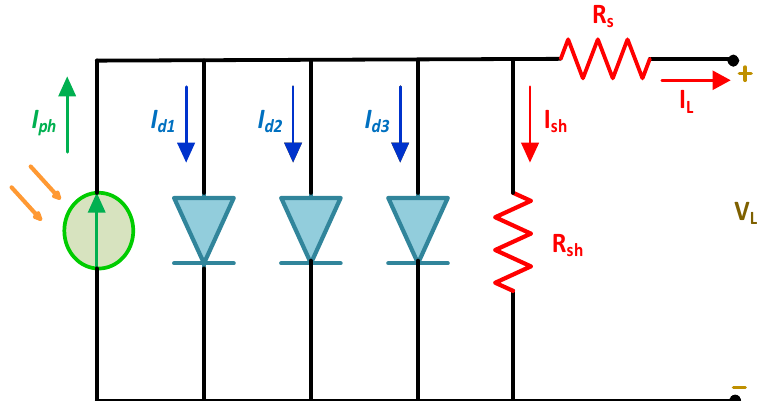
Figure 3. TDM mathematical model.